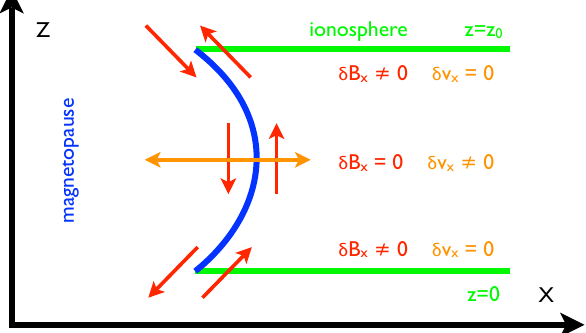
Fig. 5. Sketch of the magnetic and velocity fields and of the mag- netopause inclination. In the equatorial plane the radial velocity of the magnetopause ( δv x ) is strongest. At the ionospheres no bound- ary motion takes place. The consequent inclination of the magne- topause corresponds with the inclination of the magnetic field in both half spaces, such that it remains tangential to the